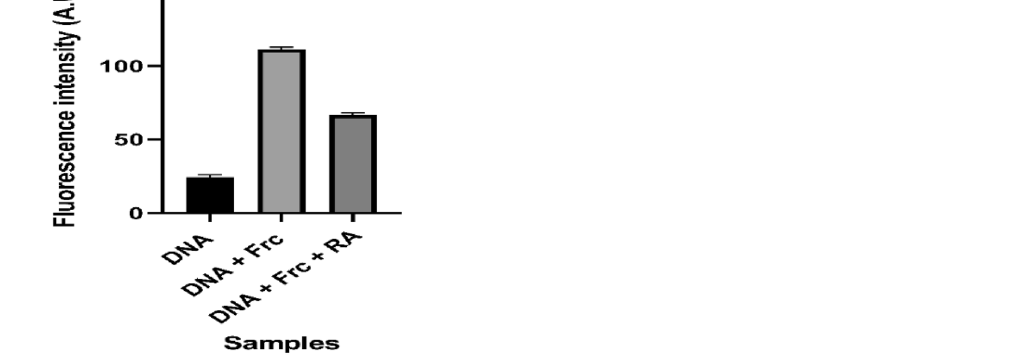
Figure 3. Fluorescence intensity of the native DNA, glycated (DNA + Fructose (Frc)) and treated with rosmarinic acid (RA). The experiments were performed in